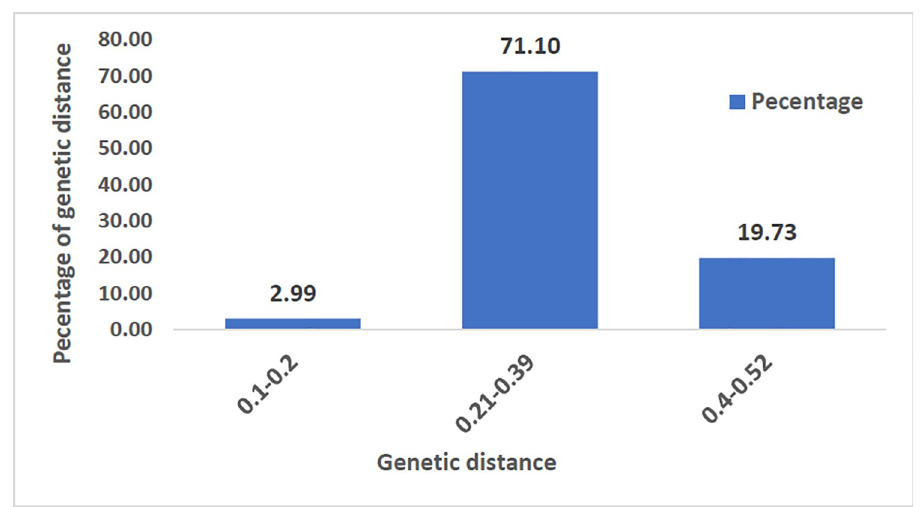
Fig 2. Percentage distribution of pairwise genetic distance for 99 groundnut genotypes with 16,363 SNPs.